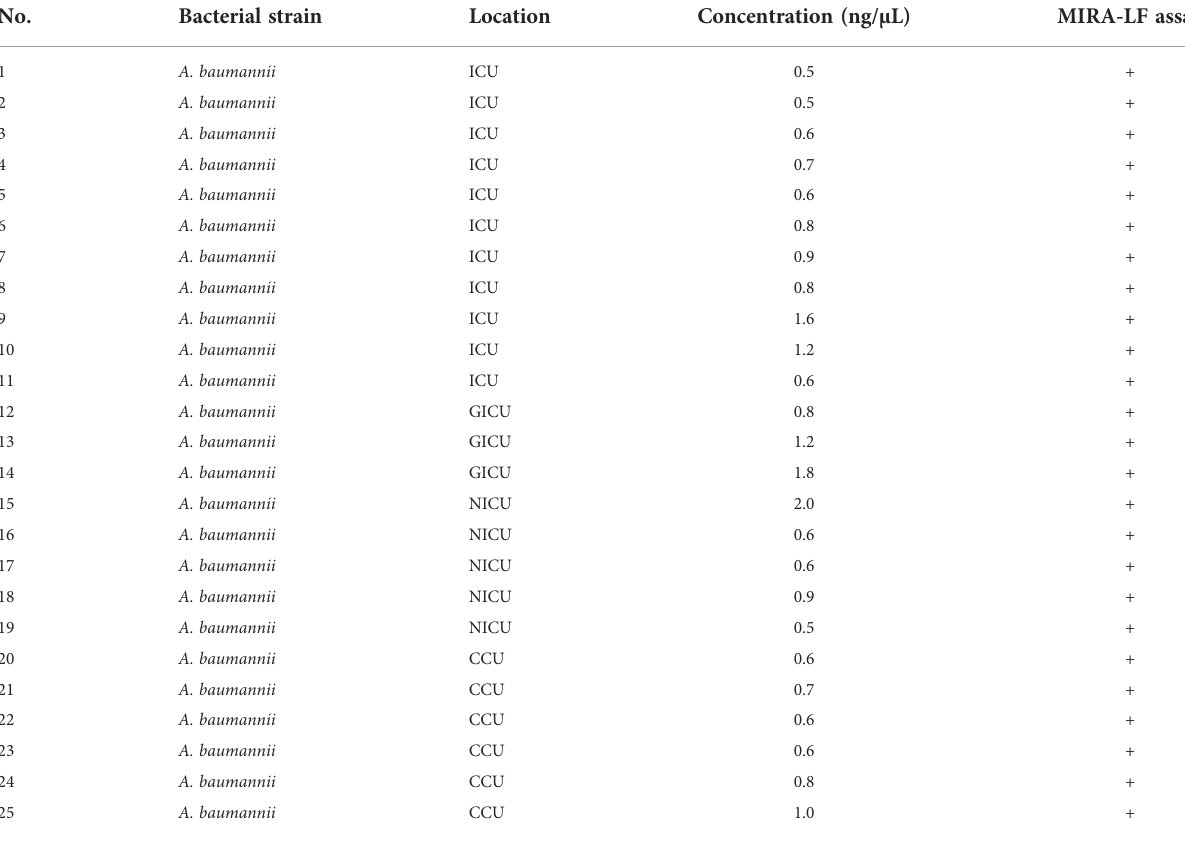
TABLE 2 Characteristics of the Fifty isolates used for validation of the newly MIRA-LF assay. No. Bacterial strain Location Concentration (ng/µL) MIRA-LF